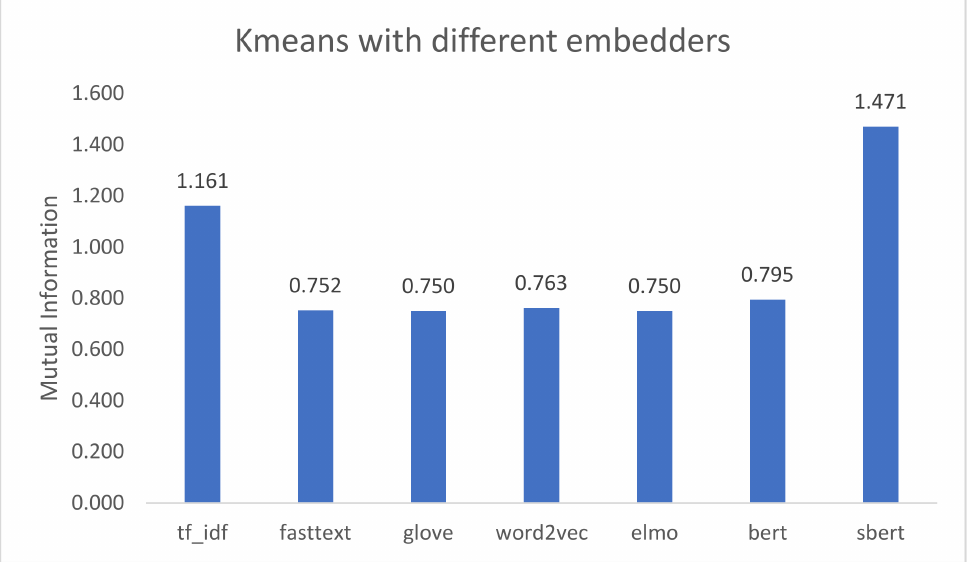
Figure 2. Kmeans performance with different word embedders on the baseball